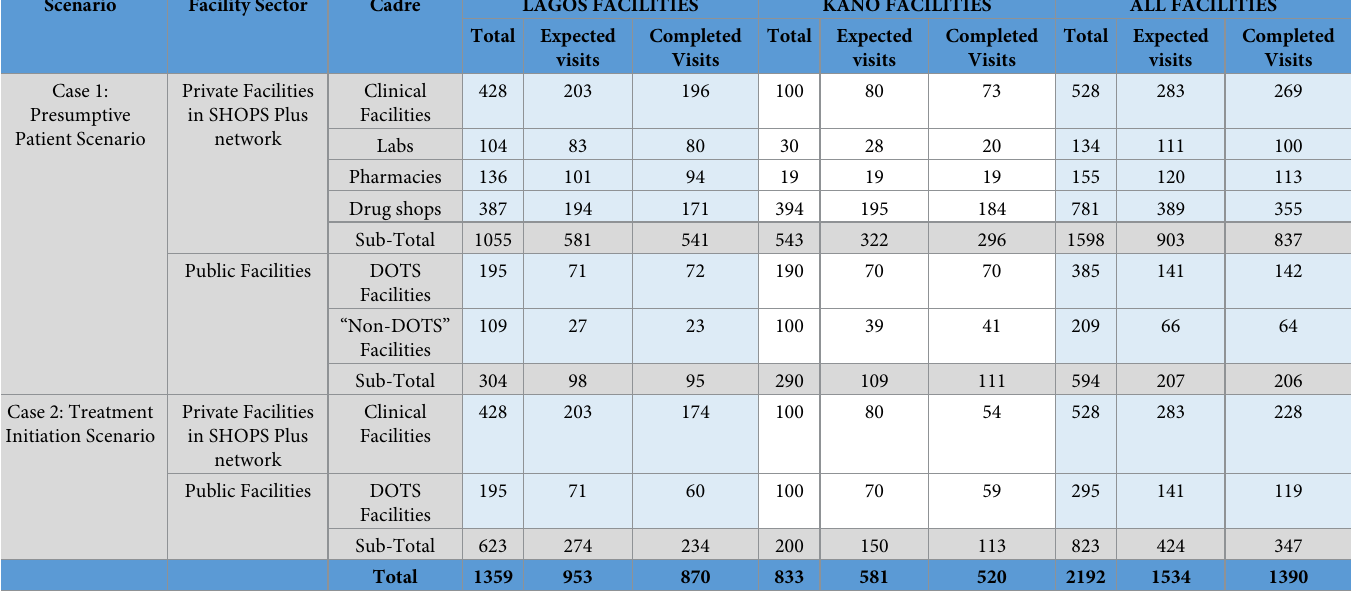
Table 2. Study sample and completed SP